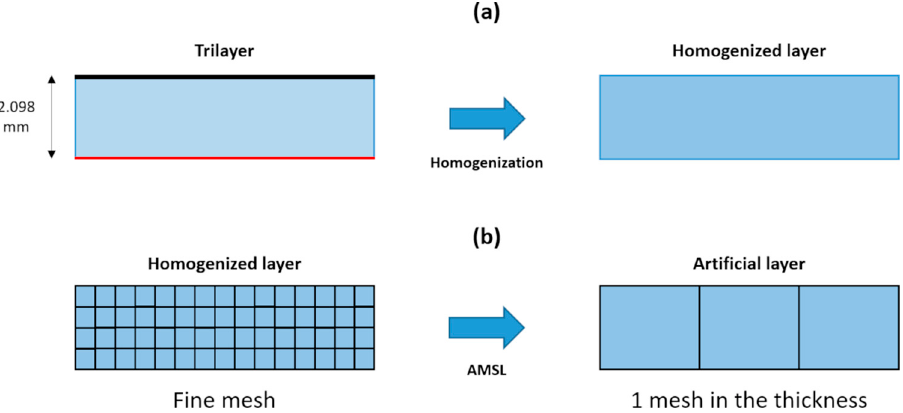
Figure 2. Schematic diagrams of the homogenization method ( a ) and the AMSL method ( b ).